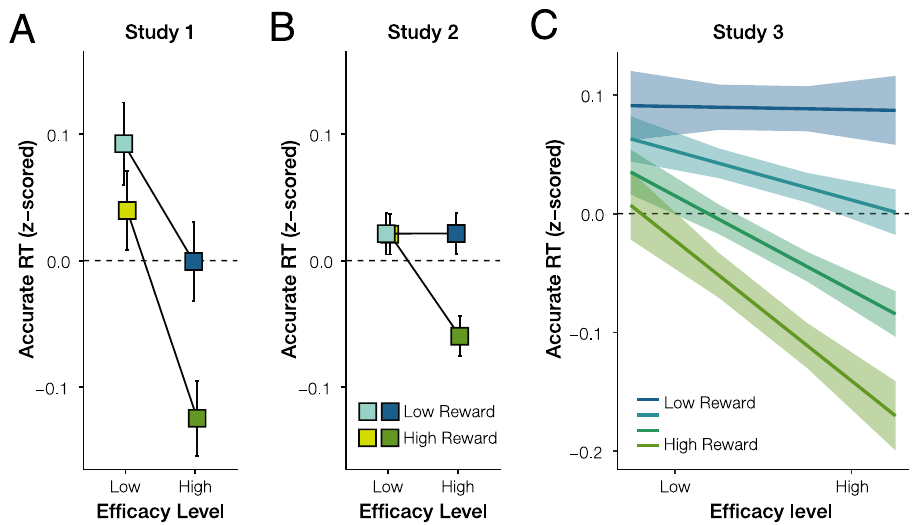
Fig. 3 Reward and ef fi cacy improve performance. Across Studies 1 – 3, participants were fastest to give a correct response when both reward and ef fi cacy were high, suggesting that these variables jointly determined control allocation. Panels A and B show average RTs for each of the four conditions when the reward ($0.10 or $1.00) and ef fi cacy (0% or 100%) were varied dichotomously in Study 1, n = 21 participants ( A ) and Study 2, n = 44 participants ( B ) (see Fig. 2). Error bars represent the within-subject standard error of the mean. Panel C shows the estimated effect of parametrically varied levels of reward ($0.10, $0.20, $0.40, or $0.80) and ef fi cacy (25%, 50%, 75%, or 100%) in Study 3, n = 35 participants, based on a linear mixed-effect model. For visual comparison with panels A and B , this is shown based on a fi t to within-subject z-scored accurate RT (therefore omitting random intercepts), but the statistics reported in the text are based on the full model. Shaded error bars represent the standard error of the mean. Source data are provided as a Source Data fi le.